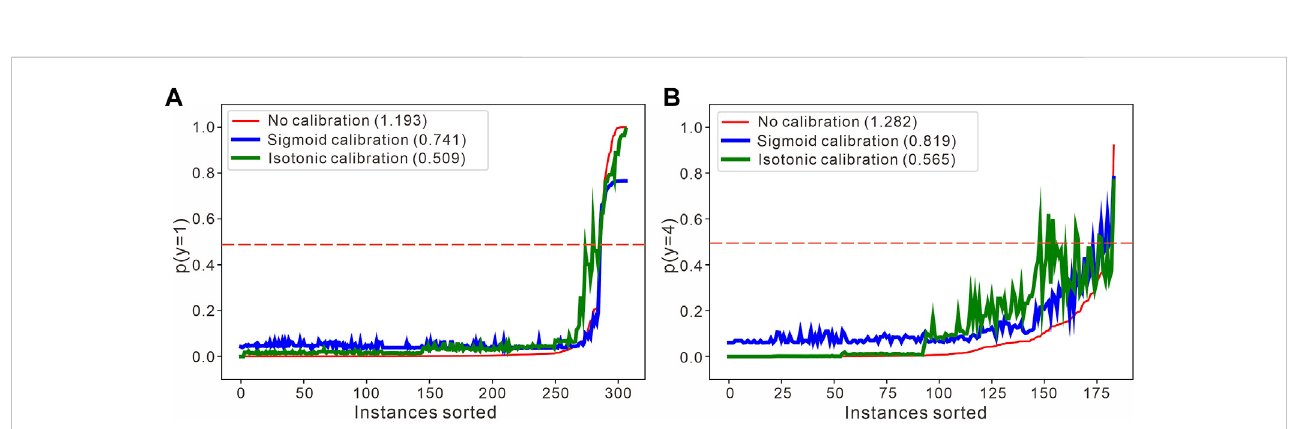
FIGURE 15 Speci fi c discriminatory adjustment of the two-segment probability calibration curve of the Sangonghe Formation. (A) The very fi ne-grained sandstone probability is taken as an example. (B) The medium-grained sandstone probability is taken as an example. The input samples are sorted according to the discriminatory recognition results as the category probabilities, and the number in the upper left corner of the fi gure represents the log